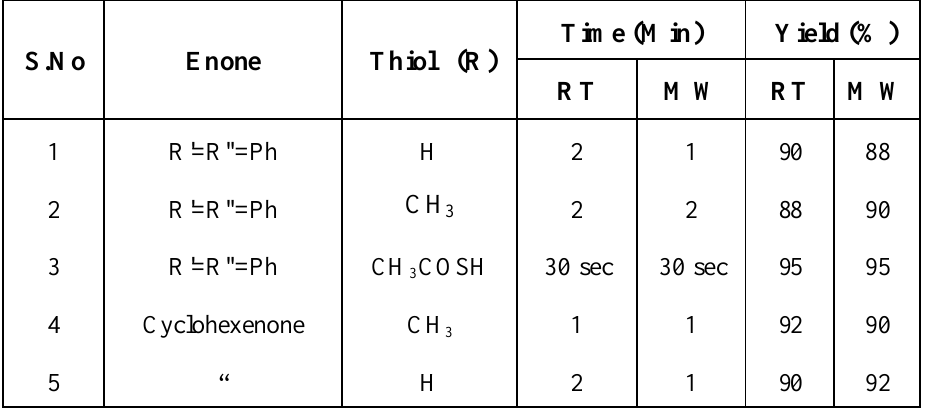
Table 3. Michael additions of thiols with acyclic and cyclic a , b -unsaturated